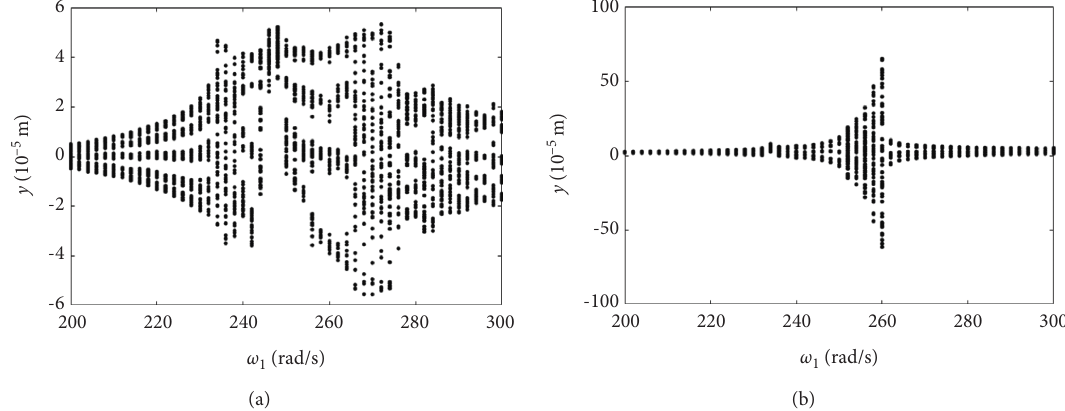
Figure 20: Bifurcation diagrams for the lateral vibration of disk 4 with rub-impact. (a) Level flight. (b) Hovering